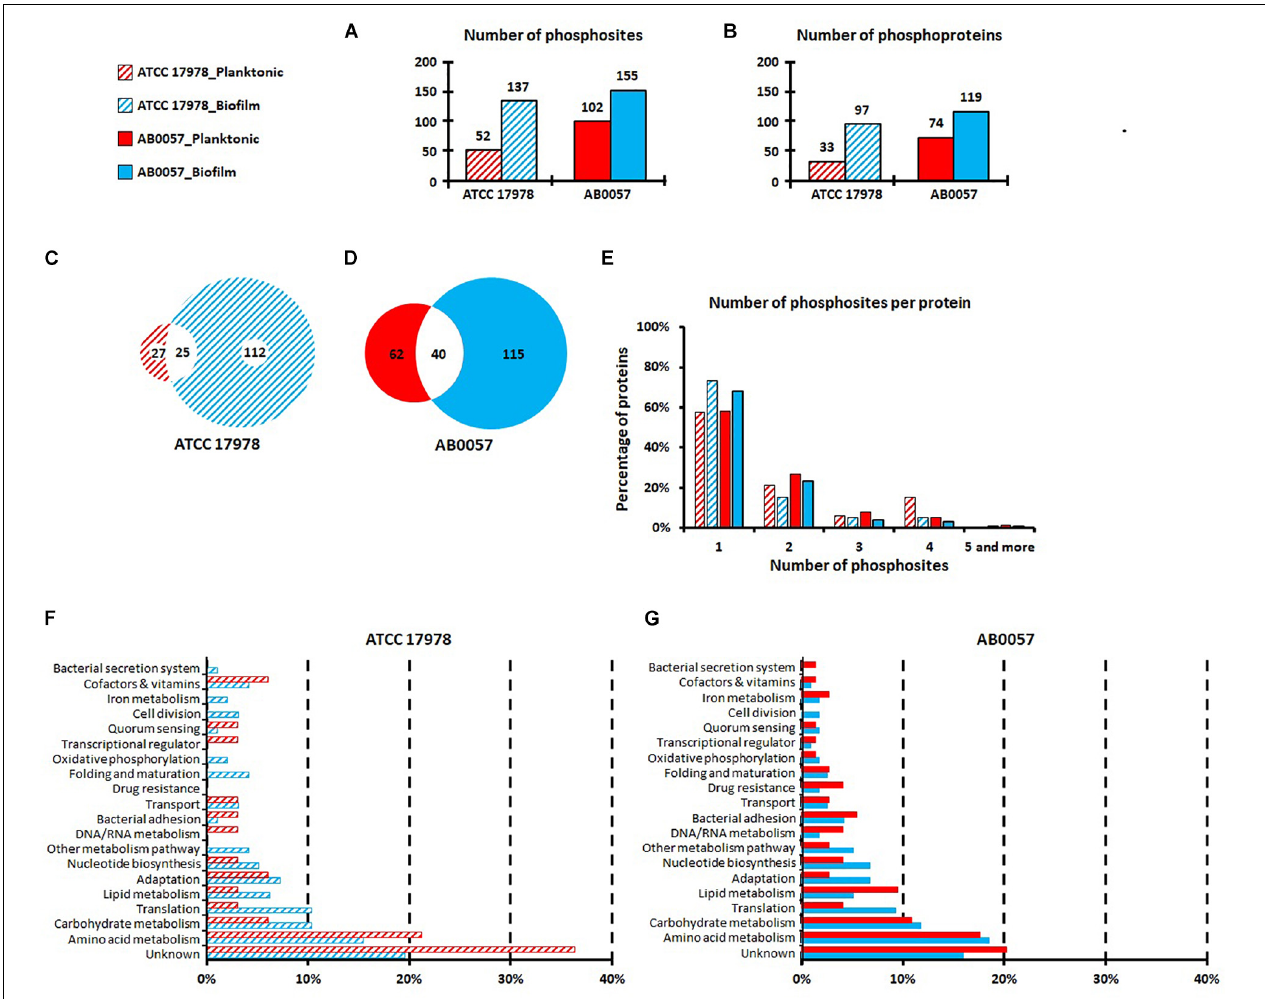
FIGURE 1 | Numbers of phosphosites (A) and phosphoproteins (B) identified in A. baumannii ATCC 17978 and AB0057 strains in planktonic and biofilm modes of growth. (C,D) Phosphosite distribution between planktonic and biofilm modes of growth for ATCC 17978 and AB0057, respectively. (E) Number of phosphosites per protein in planktonic and biofilm modes of growth for ATCC 17978 and AB0057. (F,G) Functional categories of the phosphorylated proteins in planktonic and biofilm modes of growth for ATCC 17978 and AB0057, respectively. Hatched red: ATCC 17978 in planktonic. Hatched blue: ATCC 17978 in biofilm. Red: AB0057 in planktonic. Blue: AB0057 in